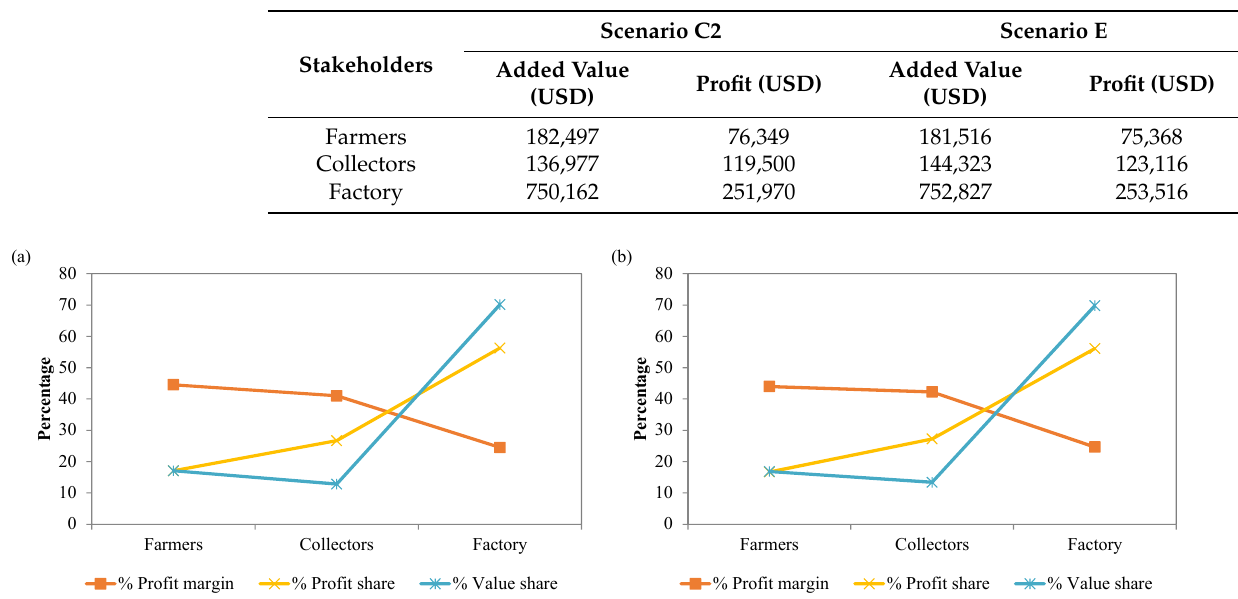
Figure 11. Profit margin, profit share, and value share of different stakeholders in new sustainable Figure 11. Pro fi t margin, pro fi t share, and value share of di ff erent stakeholders in new sustainable value chain from ( a ) scenario C2 and ( b ) scenario value chain from ( a ) scenario C2 and ( b ) scenario E.